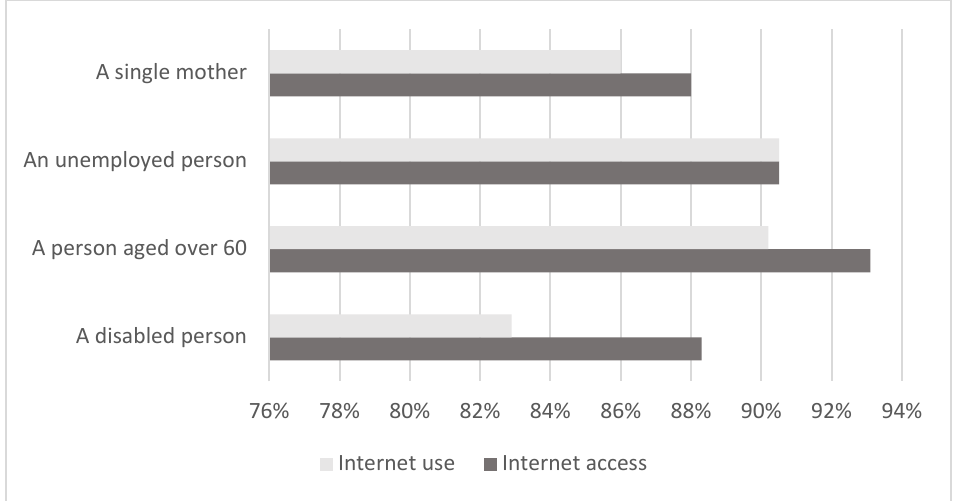
Figure 3. Internet access and usage by social status of the respondents ( n = 521). Source: own research.